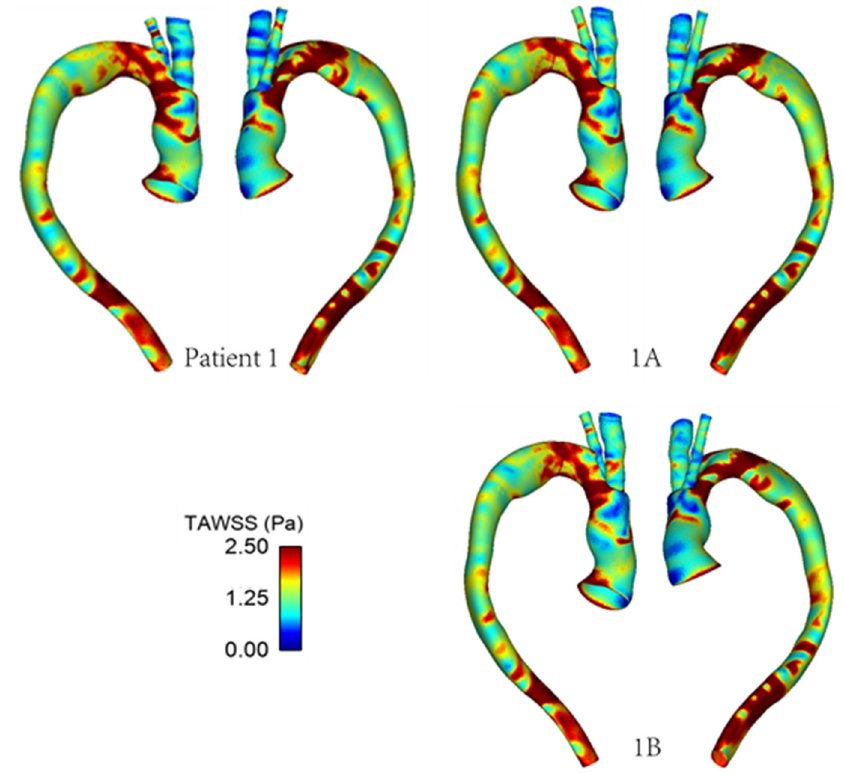
Figure 9. TAWSS distribution in the repaired aorta of Patient 1 with different tunnel branch diameters (1–12 mm, 1A–10 mm, 1B–8 mm).